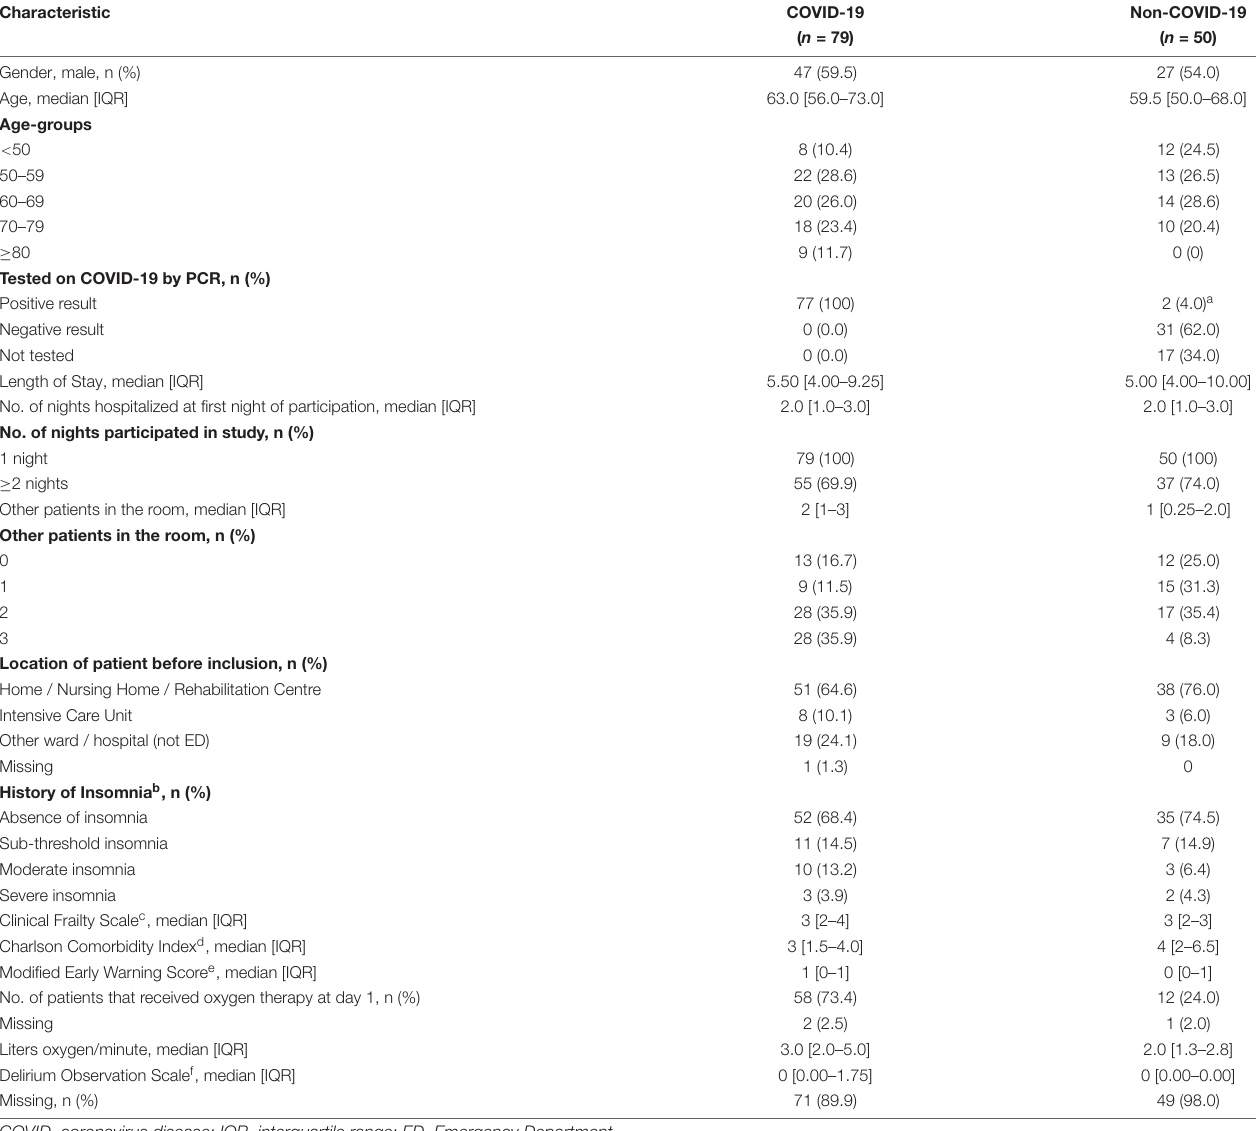
TABLE 1 | Baseline characteristics of patients with and without